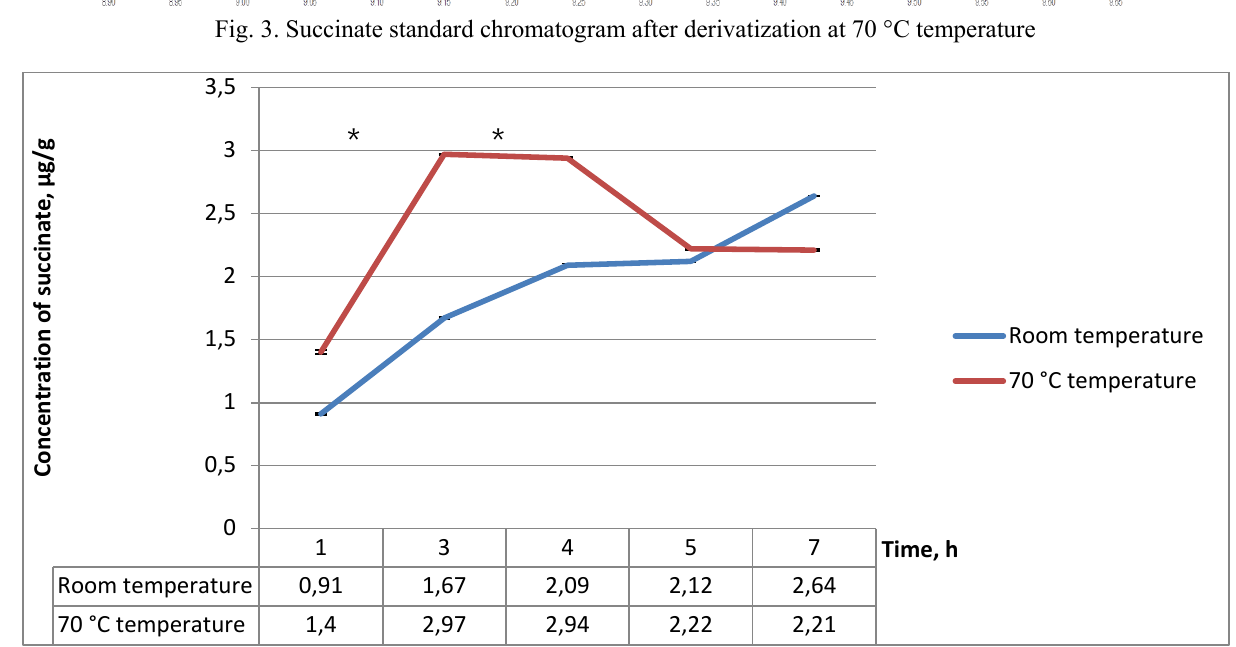
Fig. 4. The influence of temperature and time on